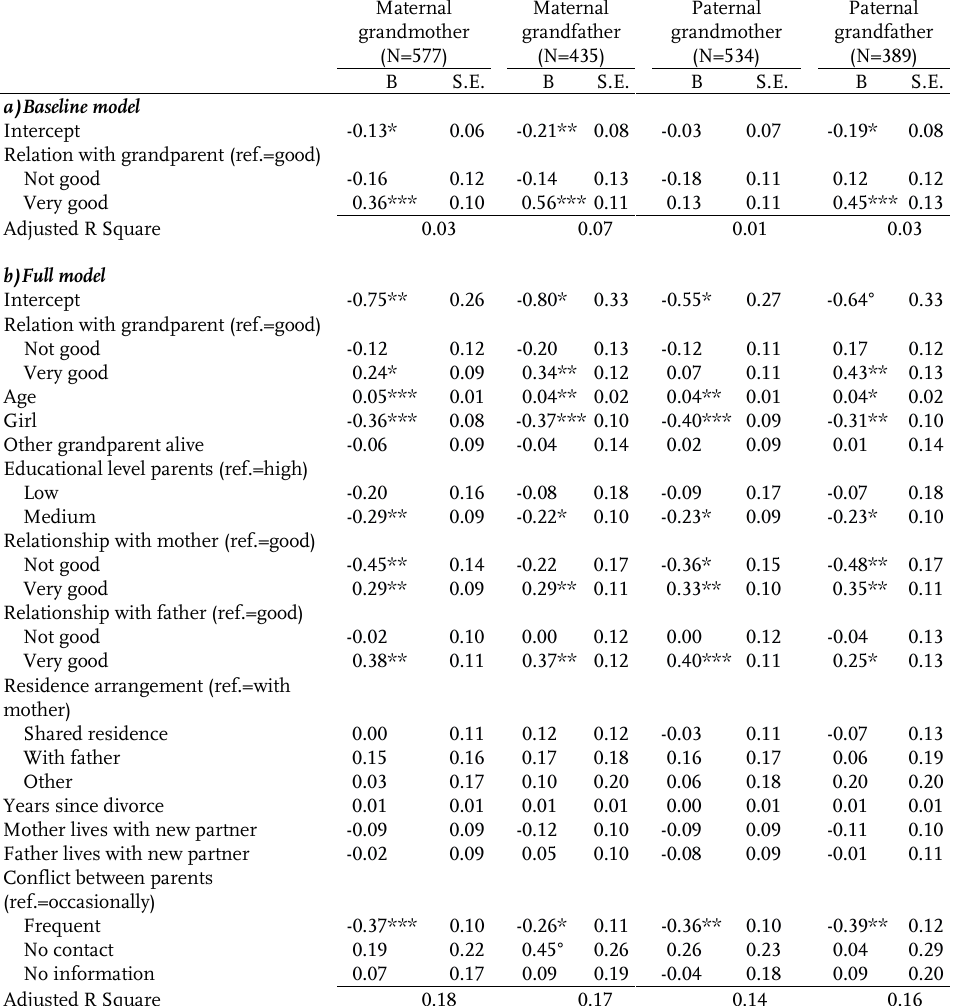
Table 3 : Linear regression analyses of grandchildren’s